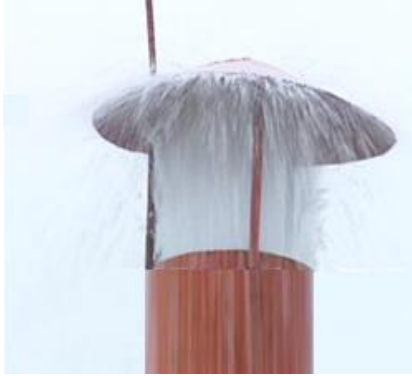
Figure 12. Gas jet at the ground 2# drainage borehole.